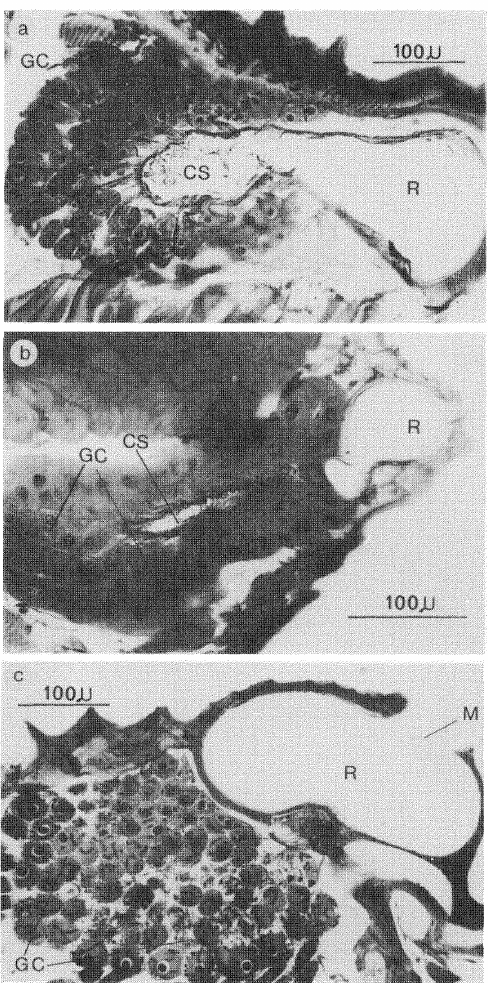
Fig. 3. (Above and facing page) Longitudinal sections through metapleural glands of workers of a. M’rmecia pilosula; b. Cerapach.vs? turneri; c. Rh.vtidoponera metallica; d. P’euh)m.vrme., pallidus; e. Novomessor aibisetosus; f. M.vrmecoc.vstus mendax. CS collecting sac; GC glandular cells; R storage